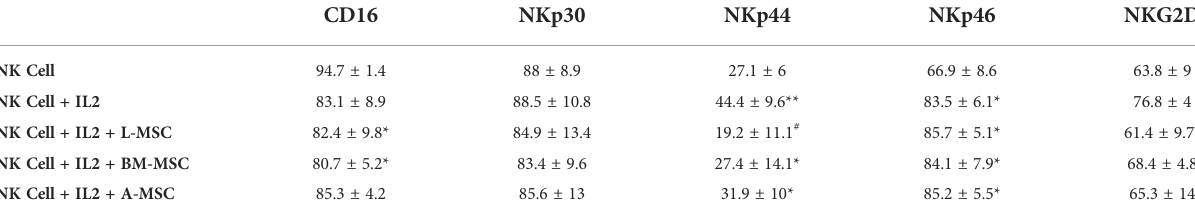
TABLE 1 Surface expression of NK receptors on CD56 dim NK cells.